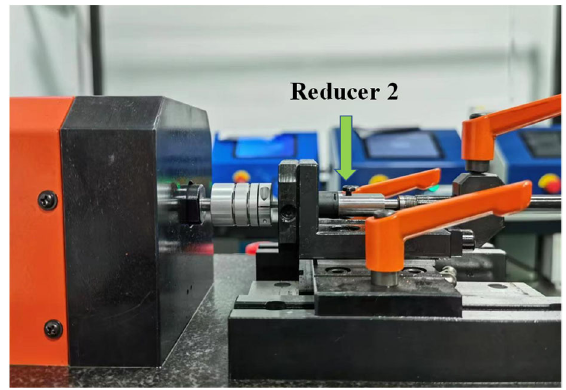
Figure 15. Clamping state of reducer